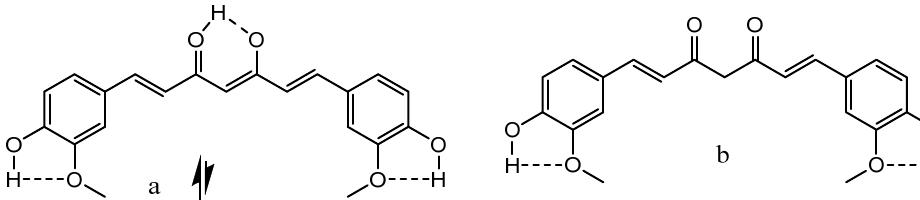
Figure 1. Curcumin. The second enolic tautomer is similar to acetylacetone (see Scheme 1). ( a ) is the enol form, ( b ) the diketo-form.